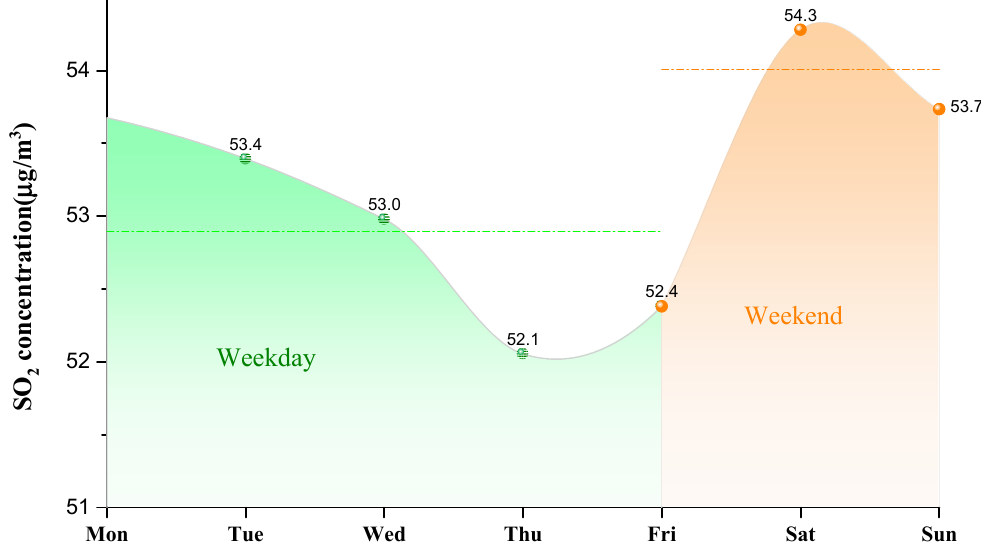
Figure 6. Daily average concentration of SO 2 during a week from 2008 to 2020.